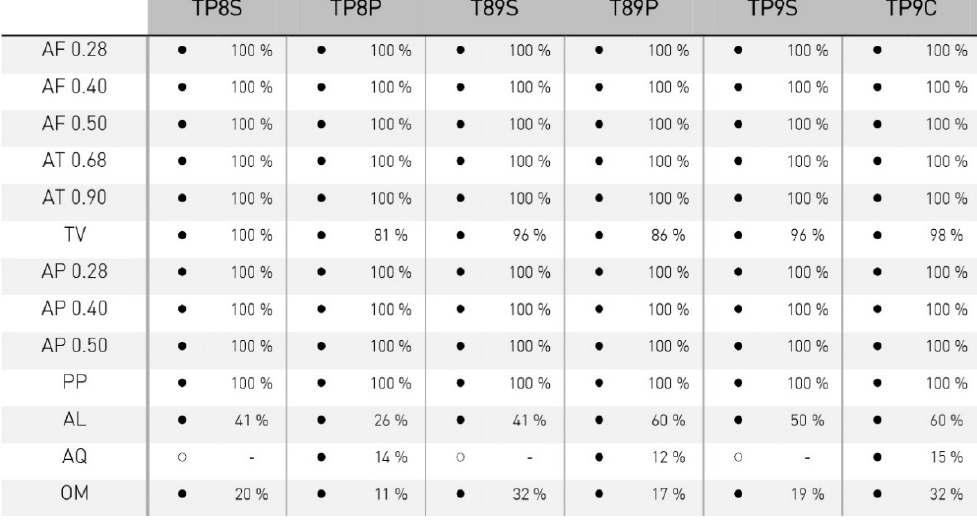
Figure 11. Climate adaptive design solutions for each of the test spaces are expressed as a percentage.